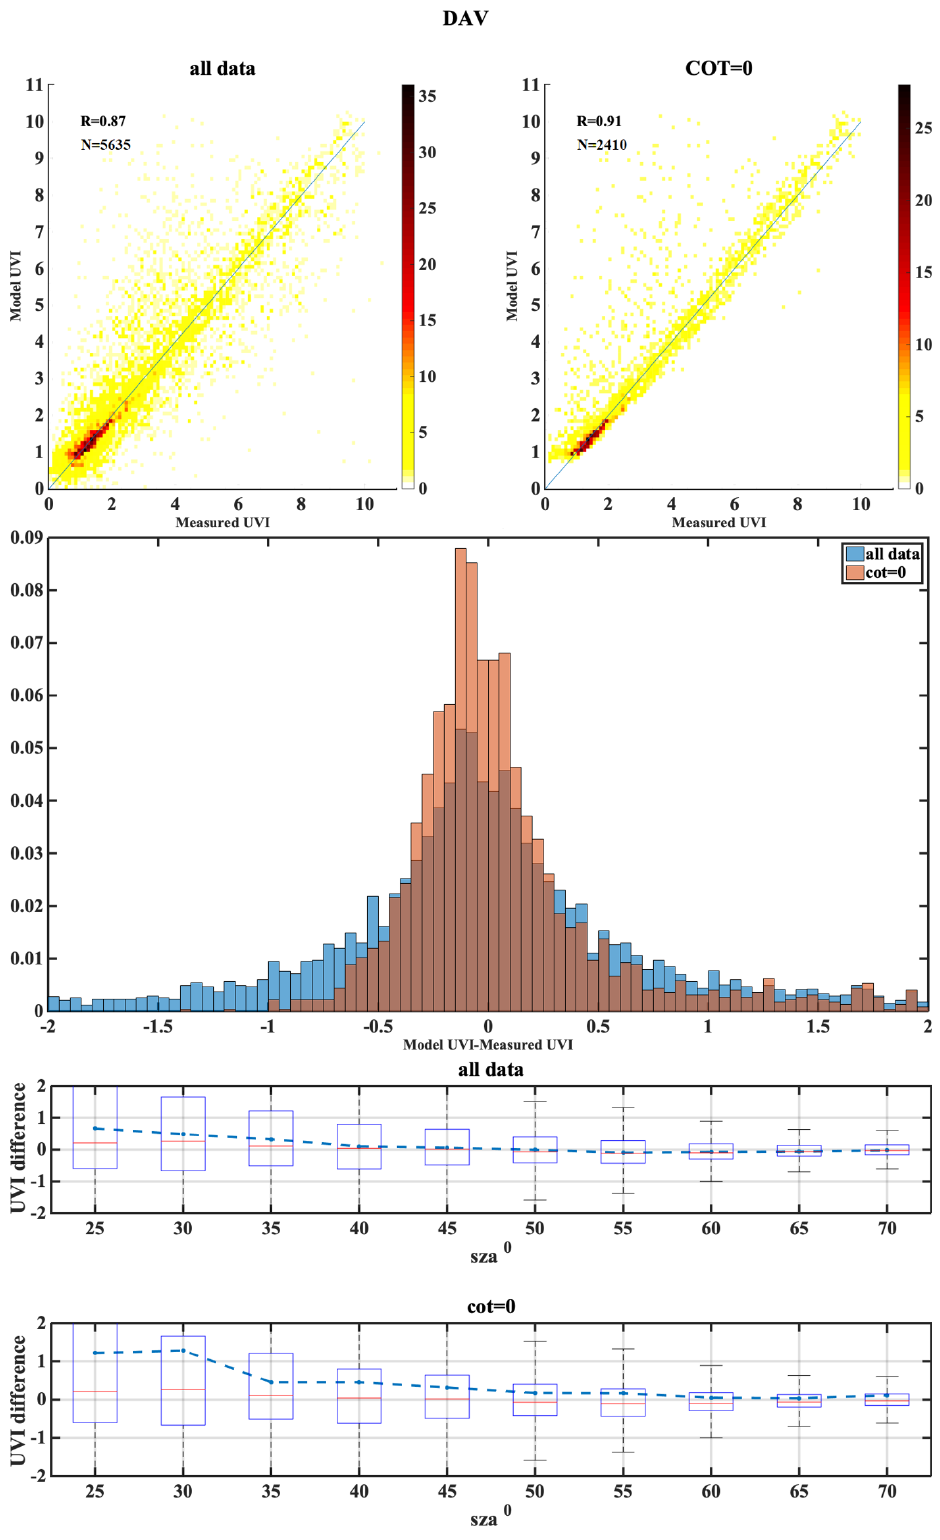
Figure A6. Same as above but for the DAV